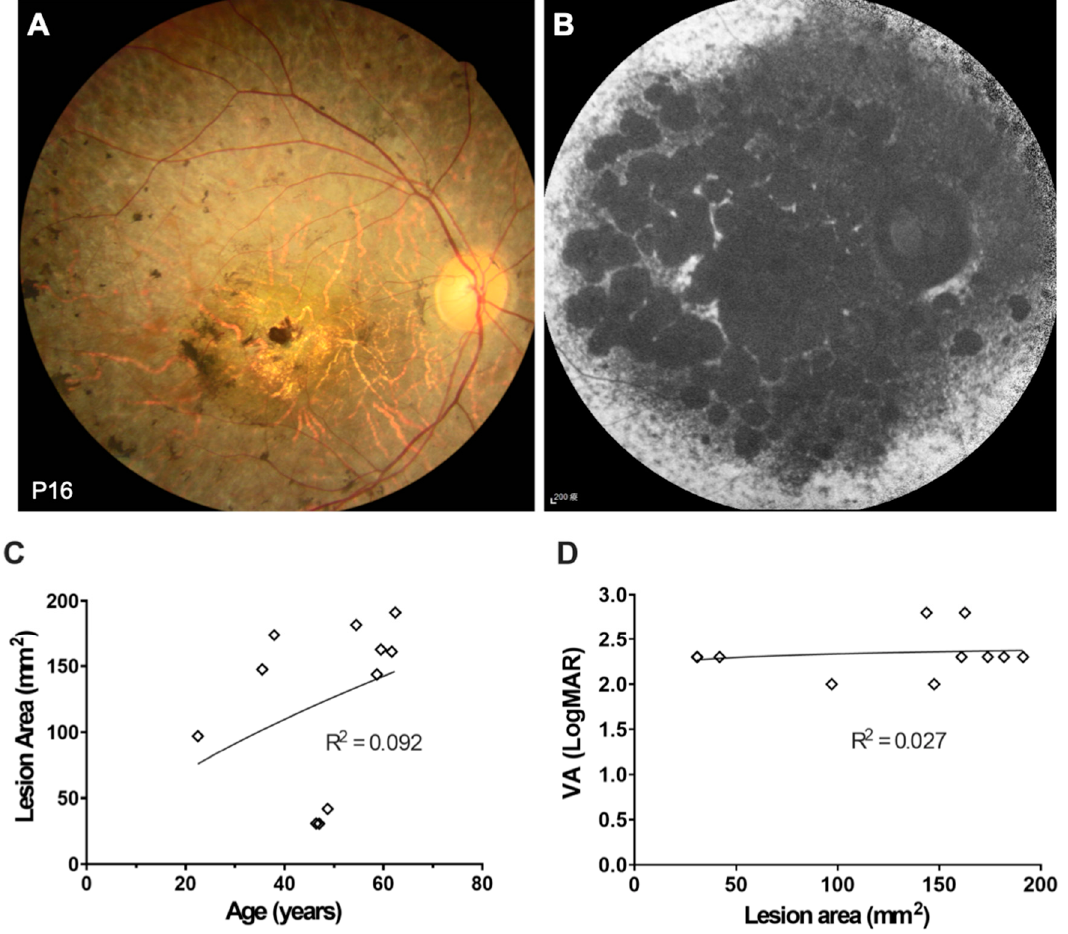
Figure 6. Clinical presentations of ABCA4 -associated retinitis pigmentosa. ( A ) Fundus color of diffuse chorioretinal atrophy with bone spicule pigmentation and central macula involvement. ( B ) Fundus autofluorescence with diffusely decreased autofluorescence and central macula involvement. ( C ) A comparison of age and the lesion area showed an increment of the lesion area accompanied with aging. ( D ) Poor visual acuity was noted in the retinitis pigmentosa patient group despite the lesion area.